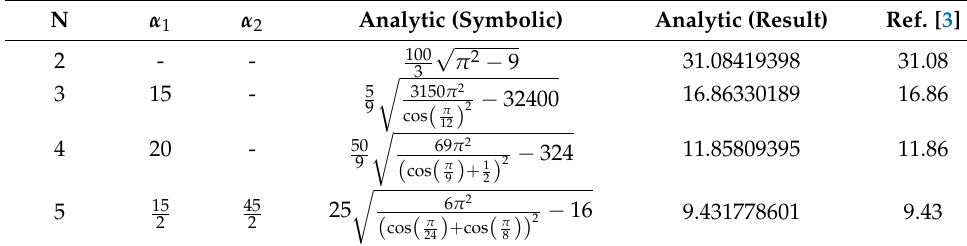
Table 1. Proposed vs. [3] LTHD comparison, %.